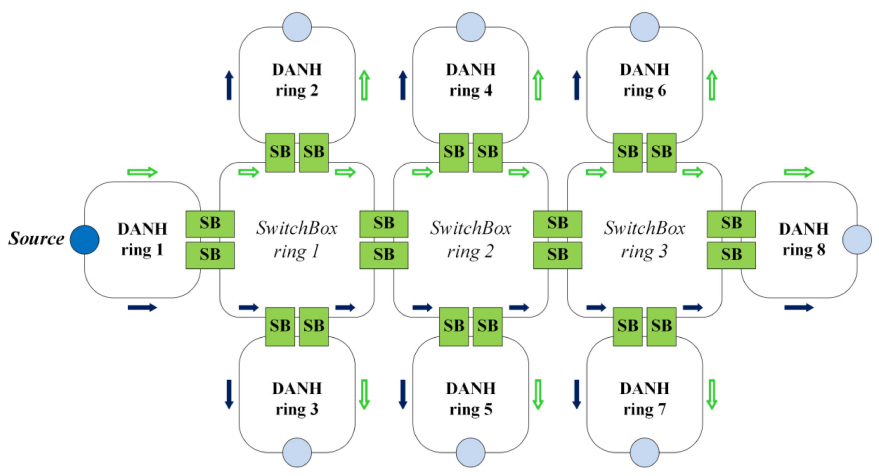
Figure 22. Network broadcast traffic under SwitchBox-based